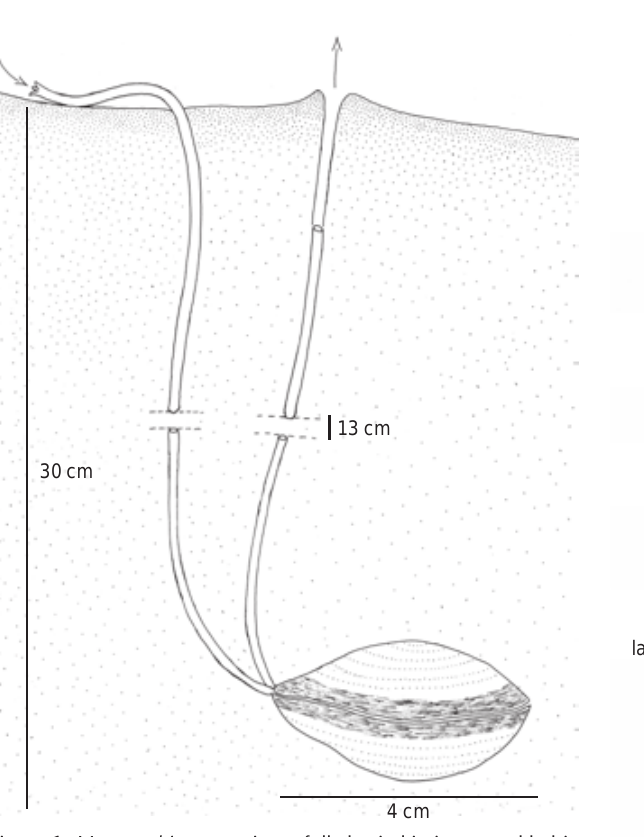
Figure 1. Macoma biota : specimen fully buried in its natural habi- tat, lying on the left shell valve. The arrows indicate the directions of the inhalant and exhalant currents.